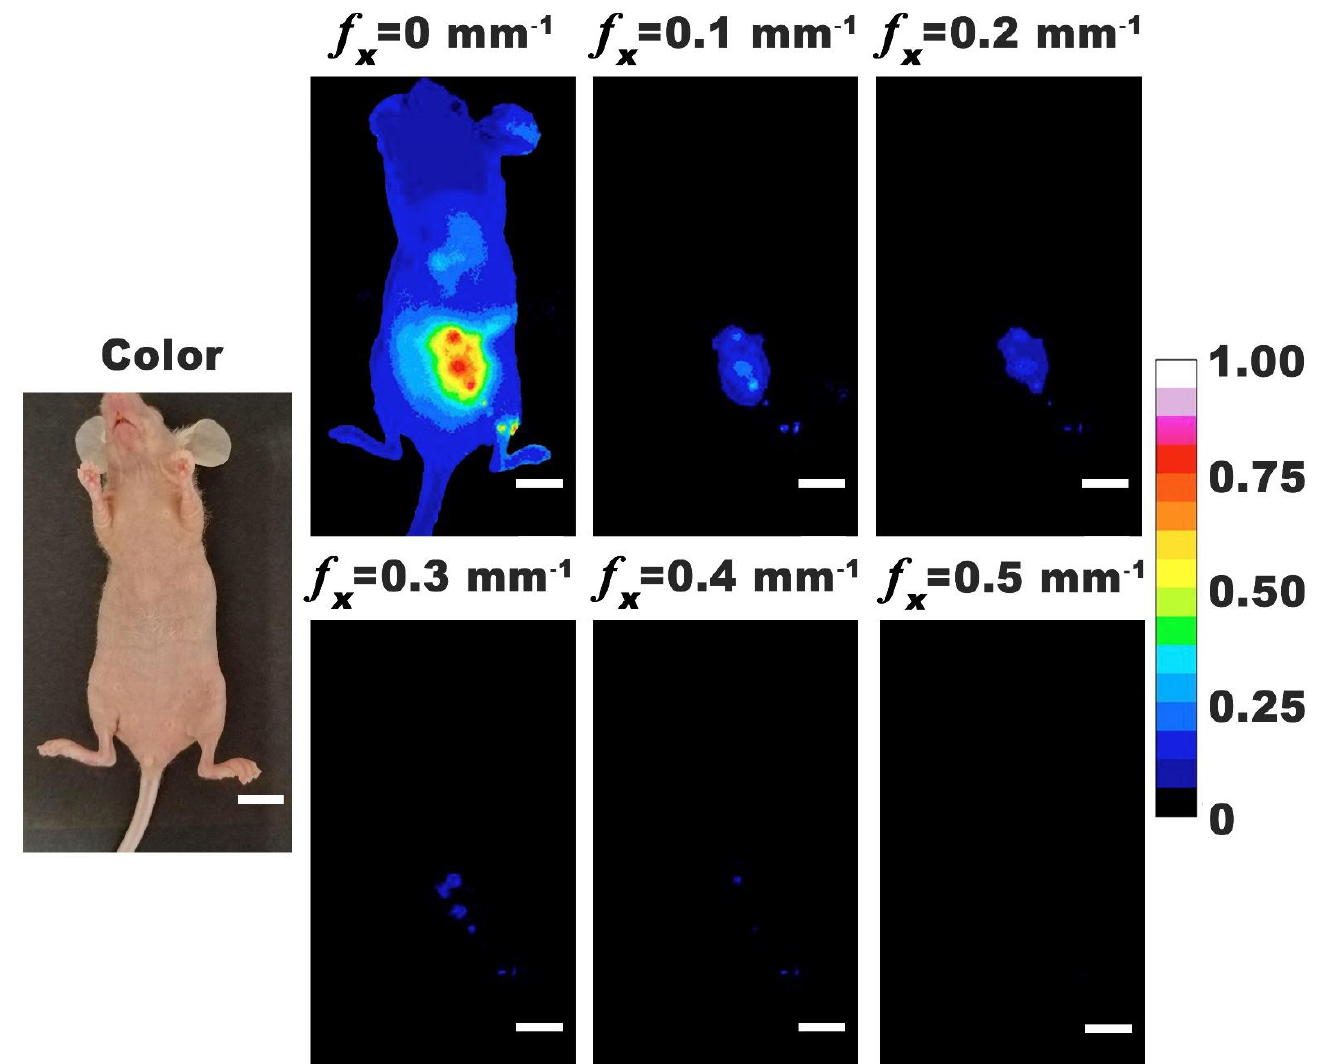
Figure 3. Representative color and normalized fluorescence images for a closed-body mouse with ovarian intraperitoneal tumors. Images were obtained at 24 h post-intraperitoneal injection of nRBCs-ICG. SMI-based imaging at spatial frequencies in the range of 0–0.5 mm −1 are presented. The color scale bar corresponds to normalized intensity associated with the fluorescent images. White scale bars on images correspond to 10 mm.